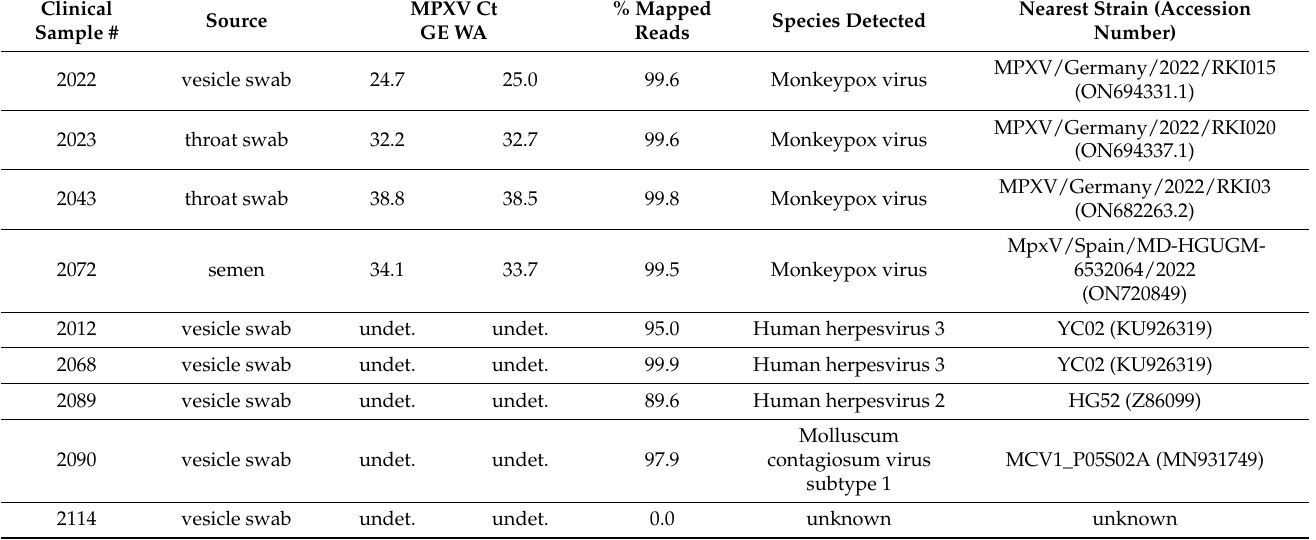
Table 4. RANS clinical samples’